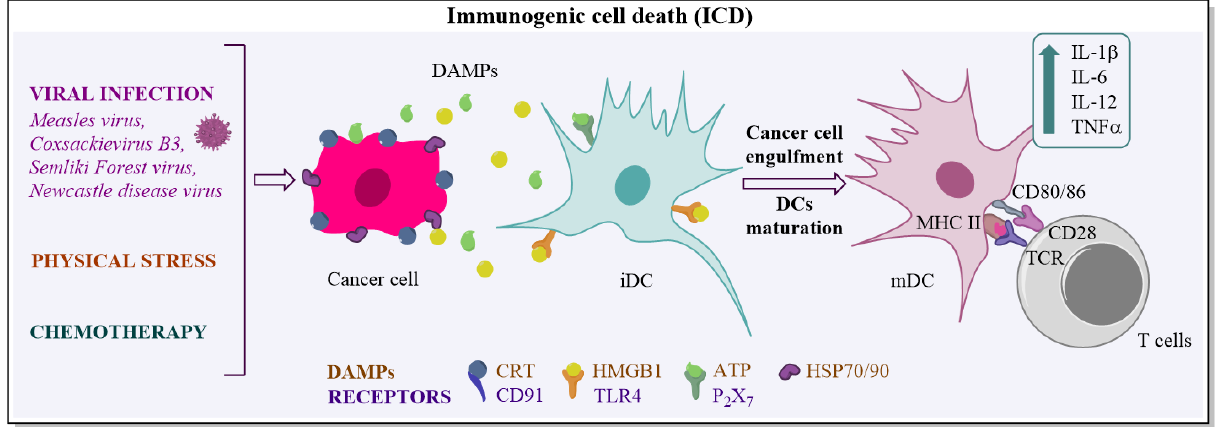
Figure 1. Activation of the adaptive immune response through immunogenic cell death (ICD).